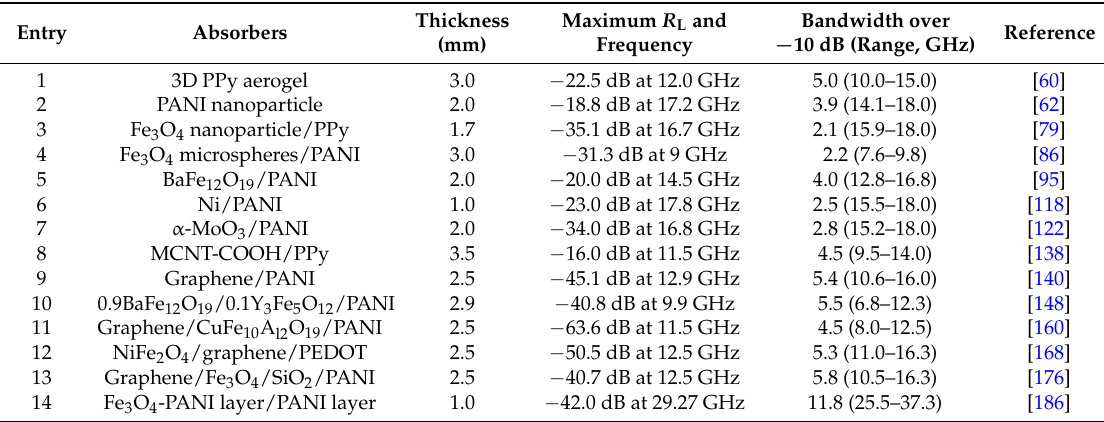
Table 1. Performance comparison of representative CP-based